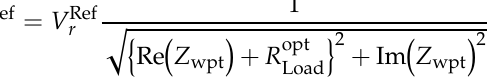
Figure 15. Optimal adaptation factor versus distance.